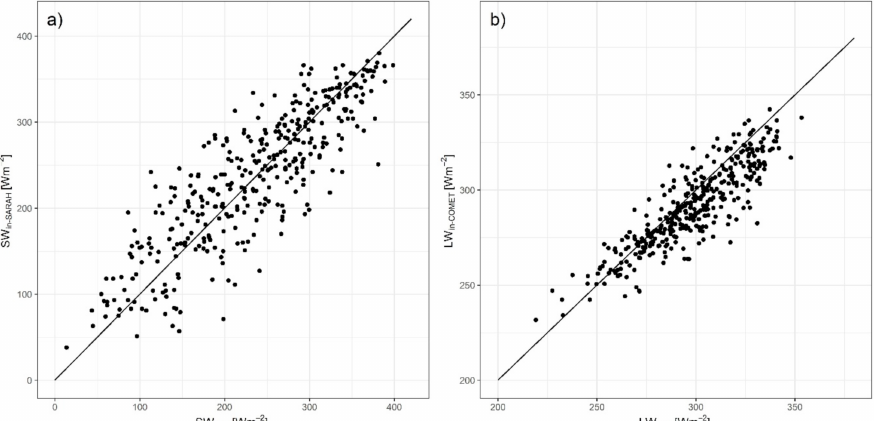
Figure 2. ( a ) Daily incoming short-wave radiation SW in-SARAH (W m − 2 ) versus SW in-gl (W m − 2 ) for the summer months (June to August) of the 2006–2009 period. ( b ) Daily incoming long-wave radiation LW in-COMET (W m − 2 ) versus LW in-gl (W m − 2 ) for the summer months (June to August) of the 2006–2009 period. In order to allow a better comparison between the considered datasets, the bisector lines are also shown in the two